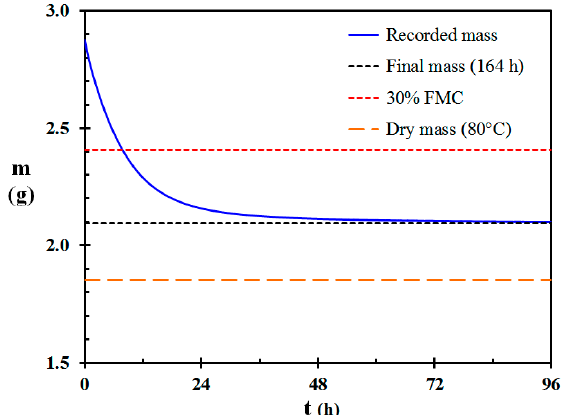
Figure 2. Recorded mass as a function of time for a 6.01 mm ( ± 0.11 mm) diameter Calluna test